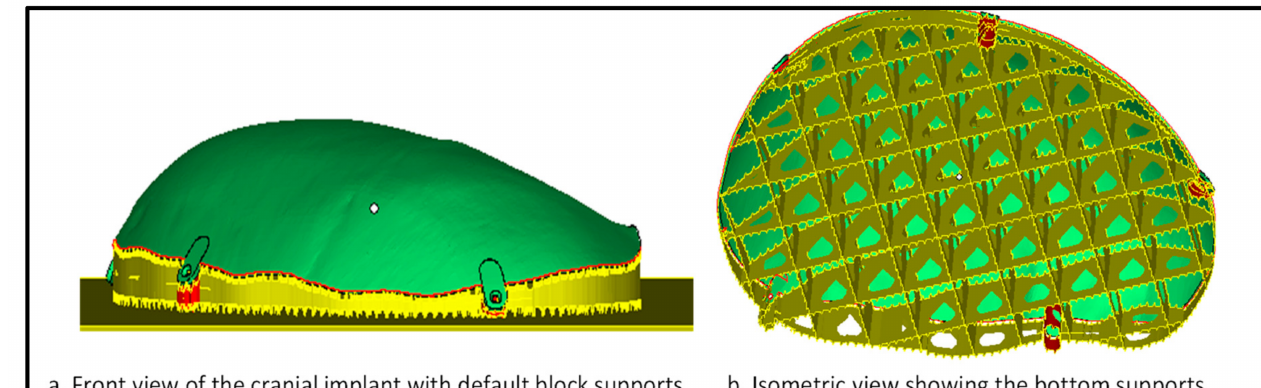
Figure 4. Virtual simulation of customized cranial implant with default block support